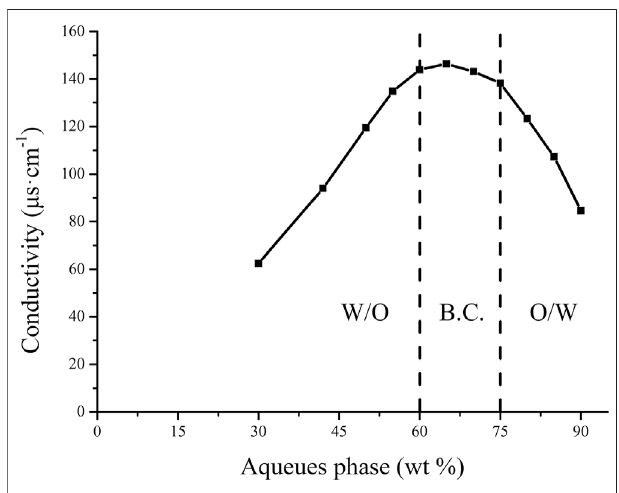
FIGURE 7 | The change curve of the electrical conductivity of the microemulsion with the aqueues